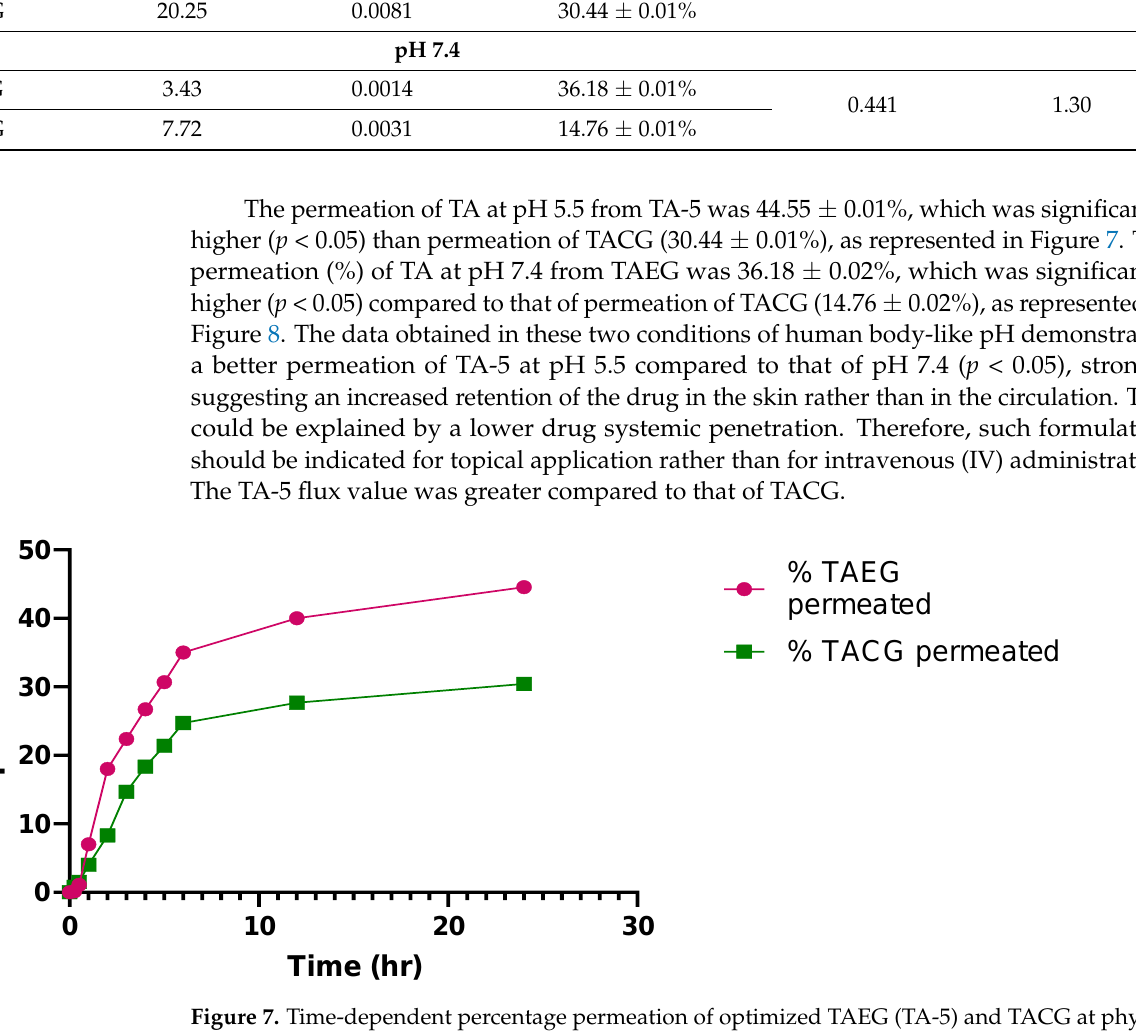
Figure 8. Time-dependent percentage permeation of optimized TAEG (TA-5) and TACG at physi- ological human skin pH 7.4 and at physiological human temperature (37 °C). Significative differ- ences were observed ( p < 0.05). 4. Conclusions Herein, a stable TAEG formulation was successfully developed. The TA ethosomal gel (TAEG) carrier TA-5 had the best EE as well as adequate PS and uniformity. Addition- ally, the formulation displayed a good skin retention capacity with increased enhance- ment ratio and high targeting efficiency. The formulation elicited prolonged action for sustained drug delivery. This study suggests that ethosomes could be modified to obtain the desired sustained delivery of TA effects simply by using different concentrations of ethanol and phospholipid amount. Taken together, the novel ethosomal system was found to be a valuable NDDS for topical TA delivery and might be used for therapeutic and cosmetic purposes.